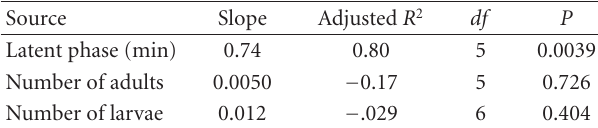
Table 4: Relationship between the total number of foraging trips to the training dish/forager and latent phase (min), the number of adults in the colony, and the number of larvae in the colony, using a simple regression